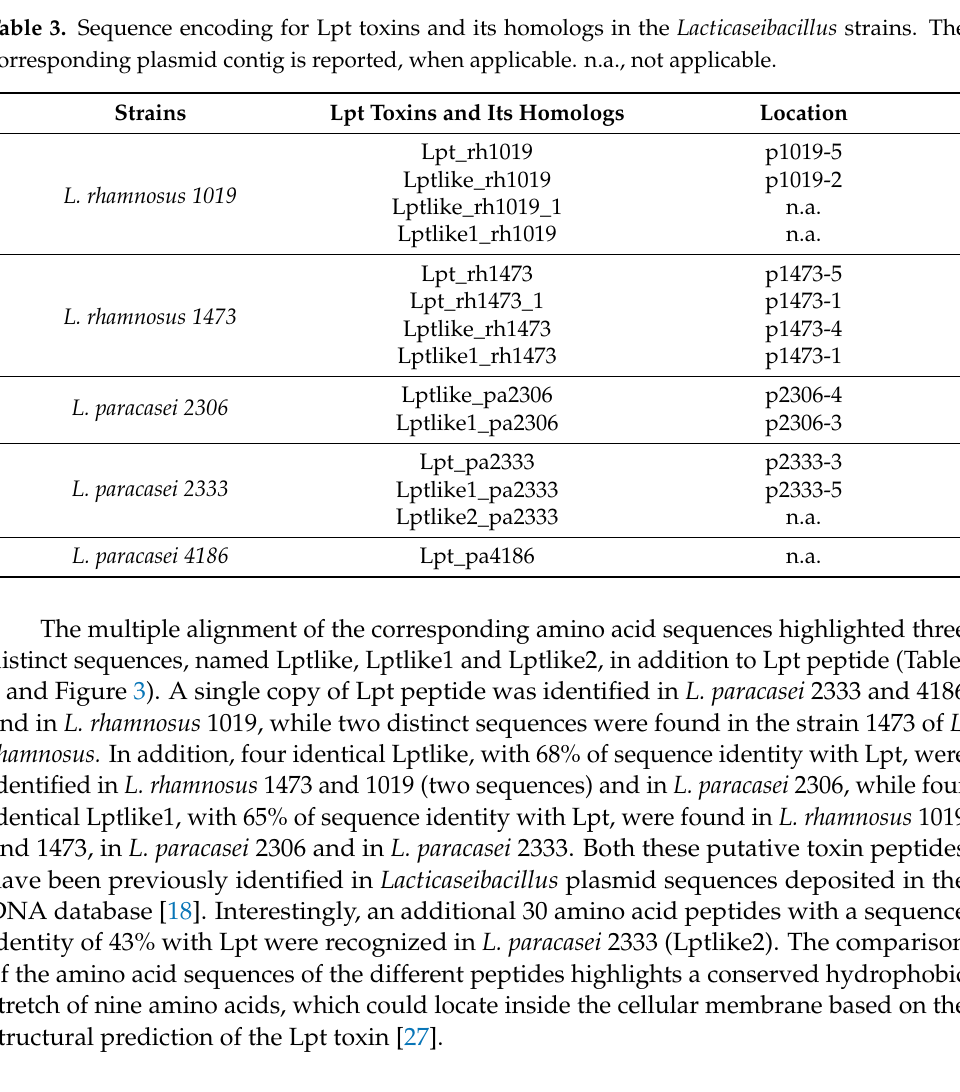
Table 3. Sequence encoding for Lpt toxins and its homologs in the Lacticaseibacillus strains. The corresponding plasmid contig is reported, when applicable. n.a., not applicable. 226